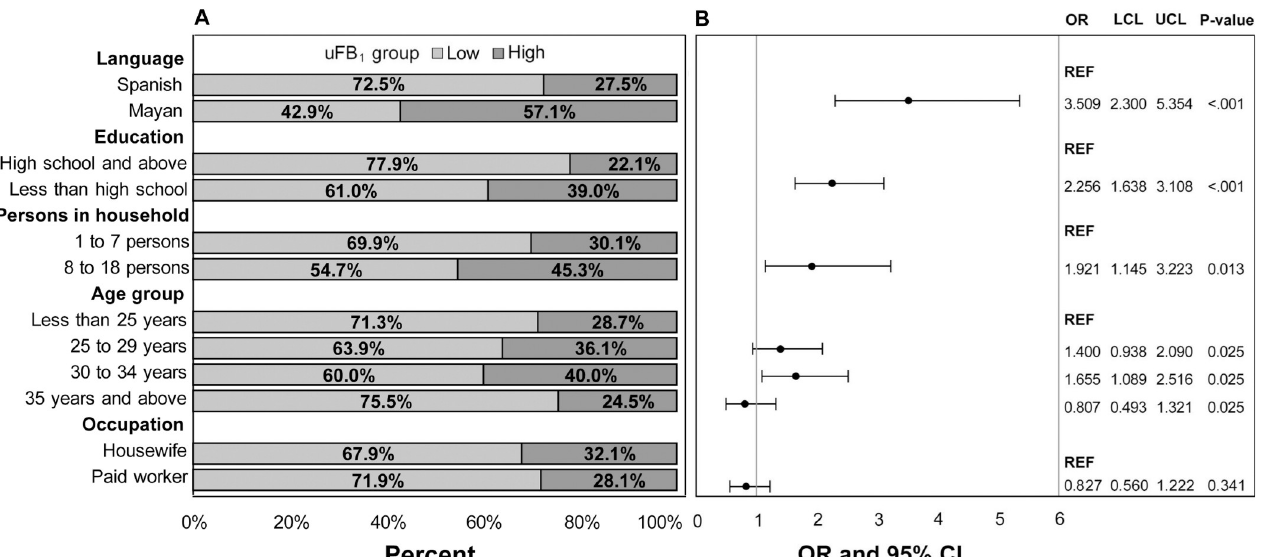
PLOS Global PublicHealth | https://doi.org/10.1371/journal.pgph.0000337 August 9,